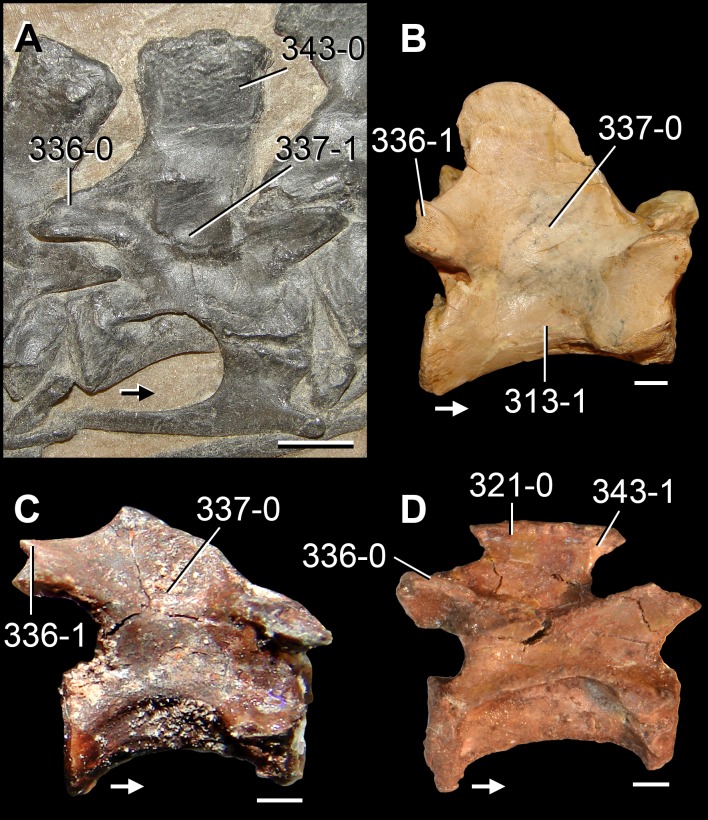
Middle and posterior cervical vertebrae of Permo-Triassic archosauromorphs in right lateral view.(A) Seventh cervical vertebra of Protorosaurus speneri (BSPG 1995 I 5 [cast of WMsN P47361]); (B) twelfth cervical vertebra of Tanystropheus longobardicus (SMNS 54654); (C) fifth or sixth cervical vertebra of Boreopricea funerea (PIN 3708/1); and (D) seventh cervical vertebra of Prolacerta broomi (BP/1/2675). Numbers indicate character-states scored in the data matrix and the arrows indicate anterior direction. Scale bars equal 1 cm in (A), 5mm in (B), and 2 mm in (C, D).